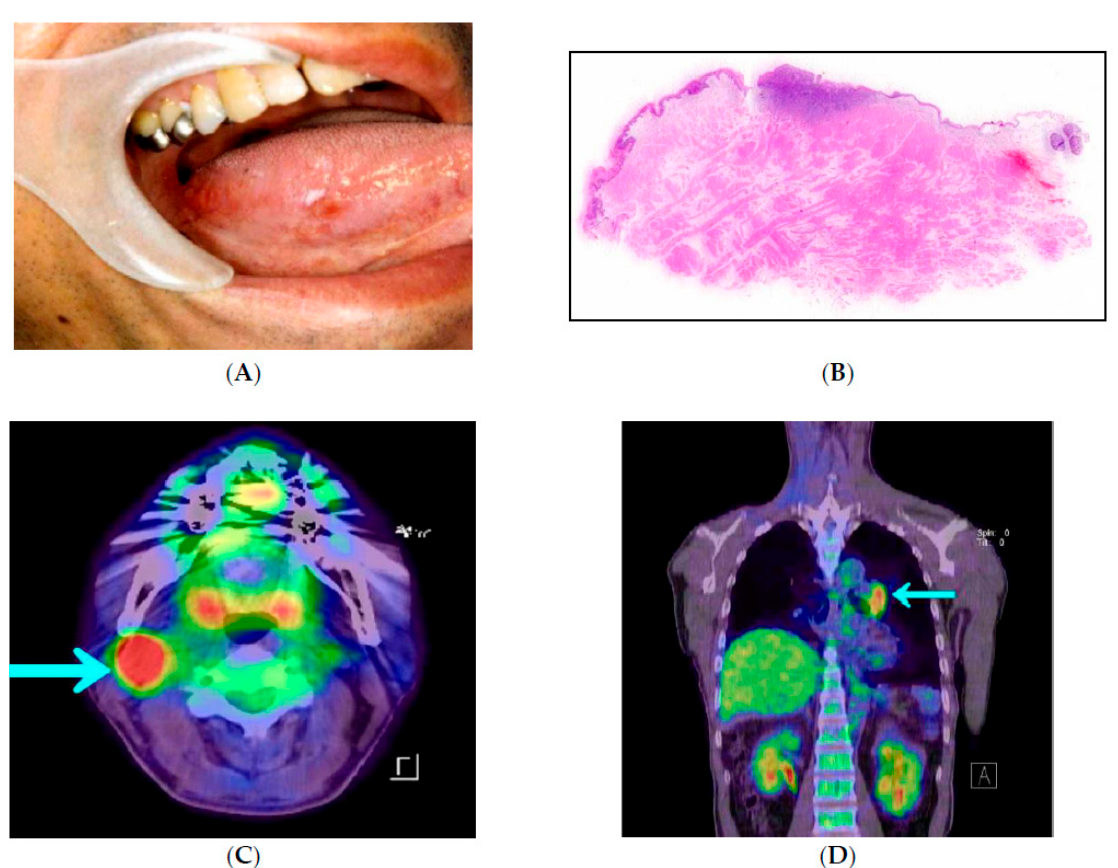
Figure 1. A 60-year-old male patient underwent partial glossectomy for right SCC of the tongue (T1N0M0, tumor diameter was 7 × 5 mm, depth of invasion was 1 mm, and degree of